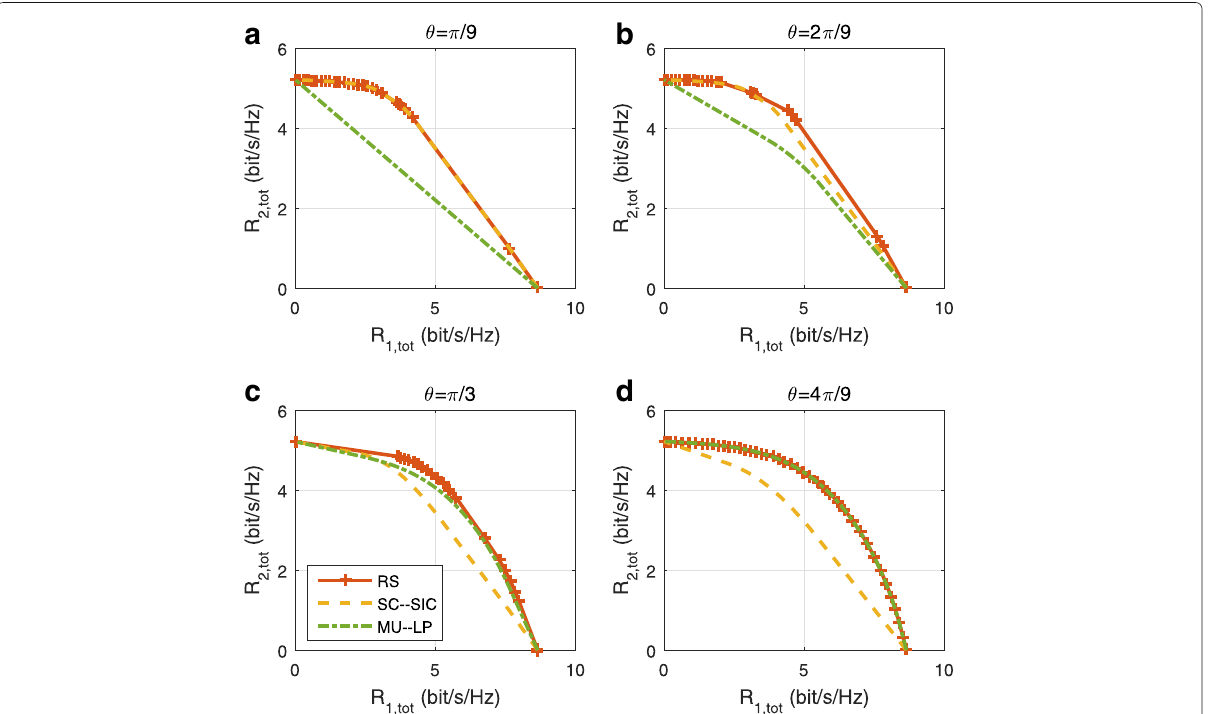
Fig. 12 Average rate region comparison of different strategies in imperfect CSIT, γ = 0.3, N t = 4, SNR = 20 dB. a θ = π/ 9. b θ = 2 π/ 9. c θ = π/ 3. d θ = 4 π/